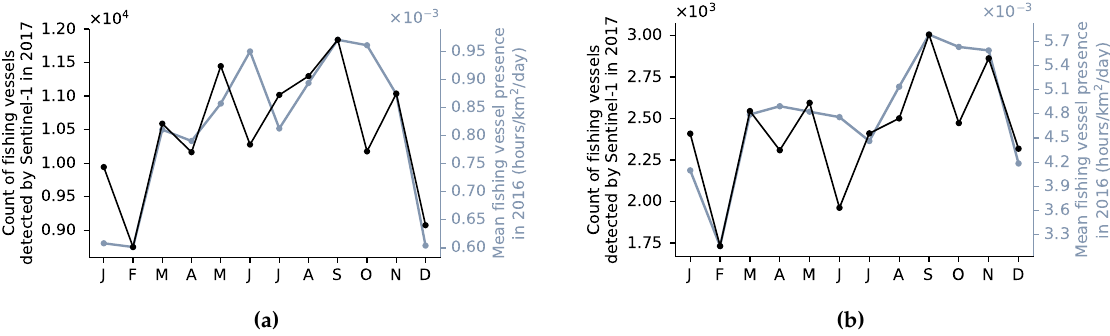
Figure 12. Comparison between the count of fishing vessels detected by Sentinel-1 in 2017 and the fishing-vessel presence from the 2016 GFW data ( a ) for the whole study area and ( b ) for the area where the classification precision of the fishing class is above